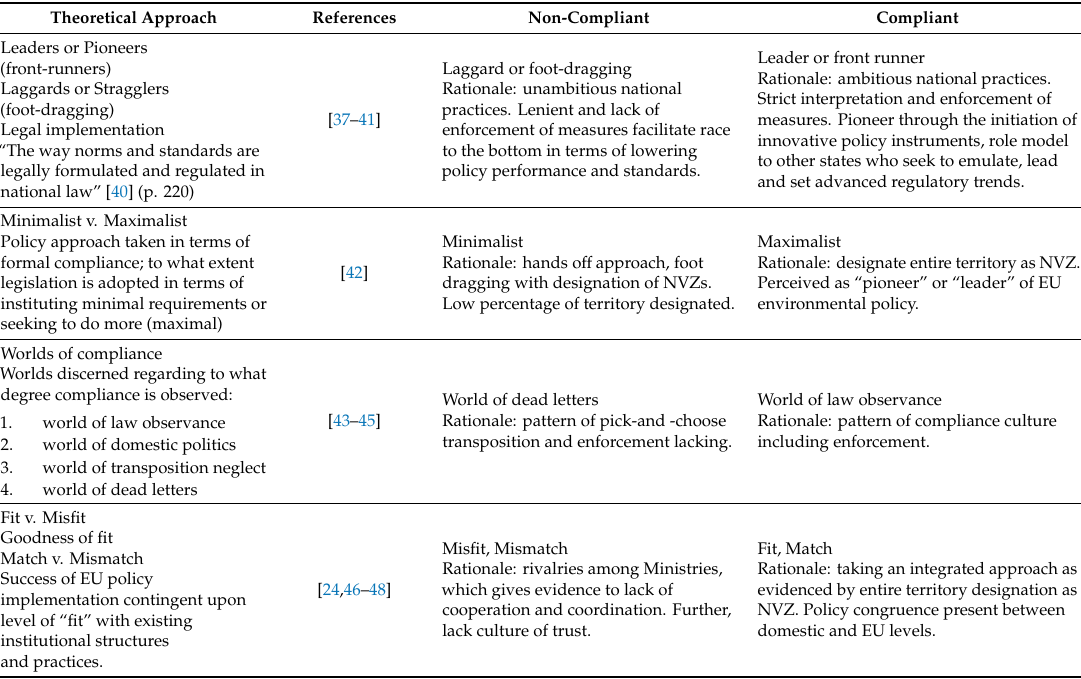
Table 1. Macro-level theories on EU Member State Directive implementation